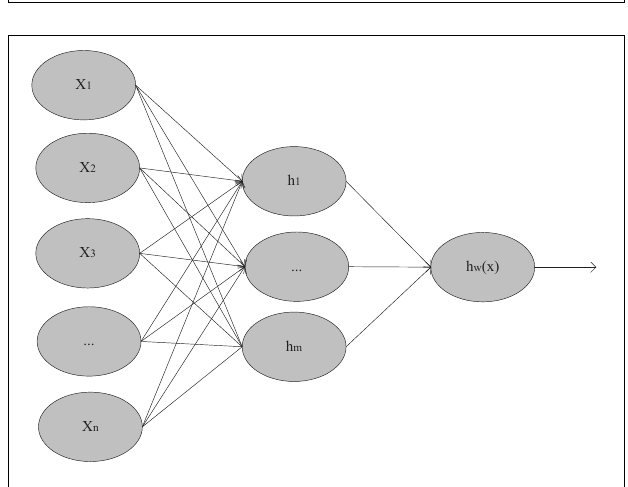
FIGURE 4 | Neural network